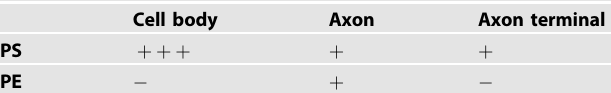
Table 2. Qualitative change in phospholipid externalization compared to control cells after 2 h exposure to 12 µM